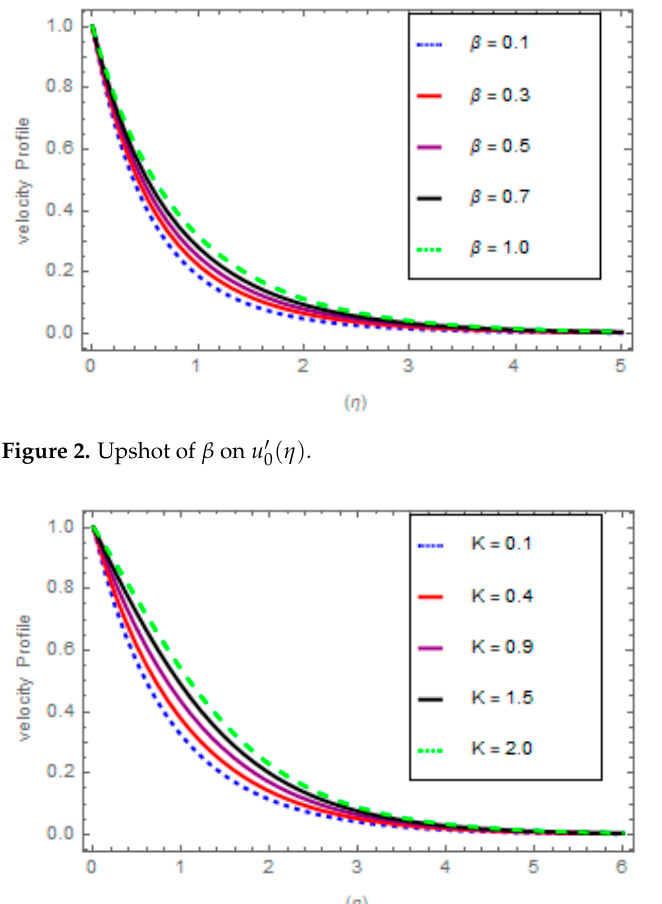
( ) ( η ) ' u η 0 ( ) 0 ' . u η 0 .